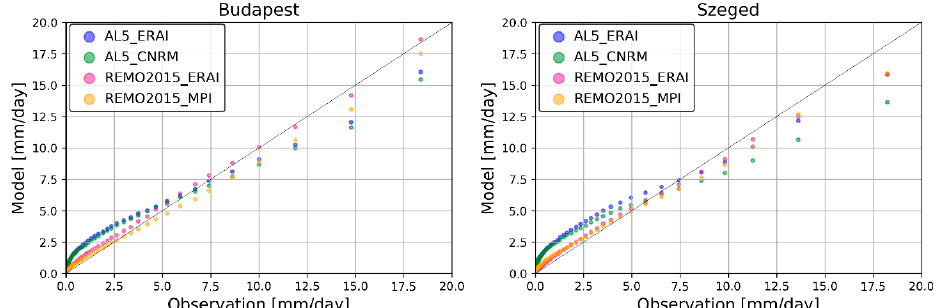
Figure 9. Quantile–quantile plot of daily precipitation for 1981–2000 in Budapest and Szeged based on four RCM simulations and the CarpatClim-HU observation dataset.